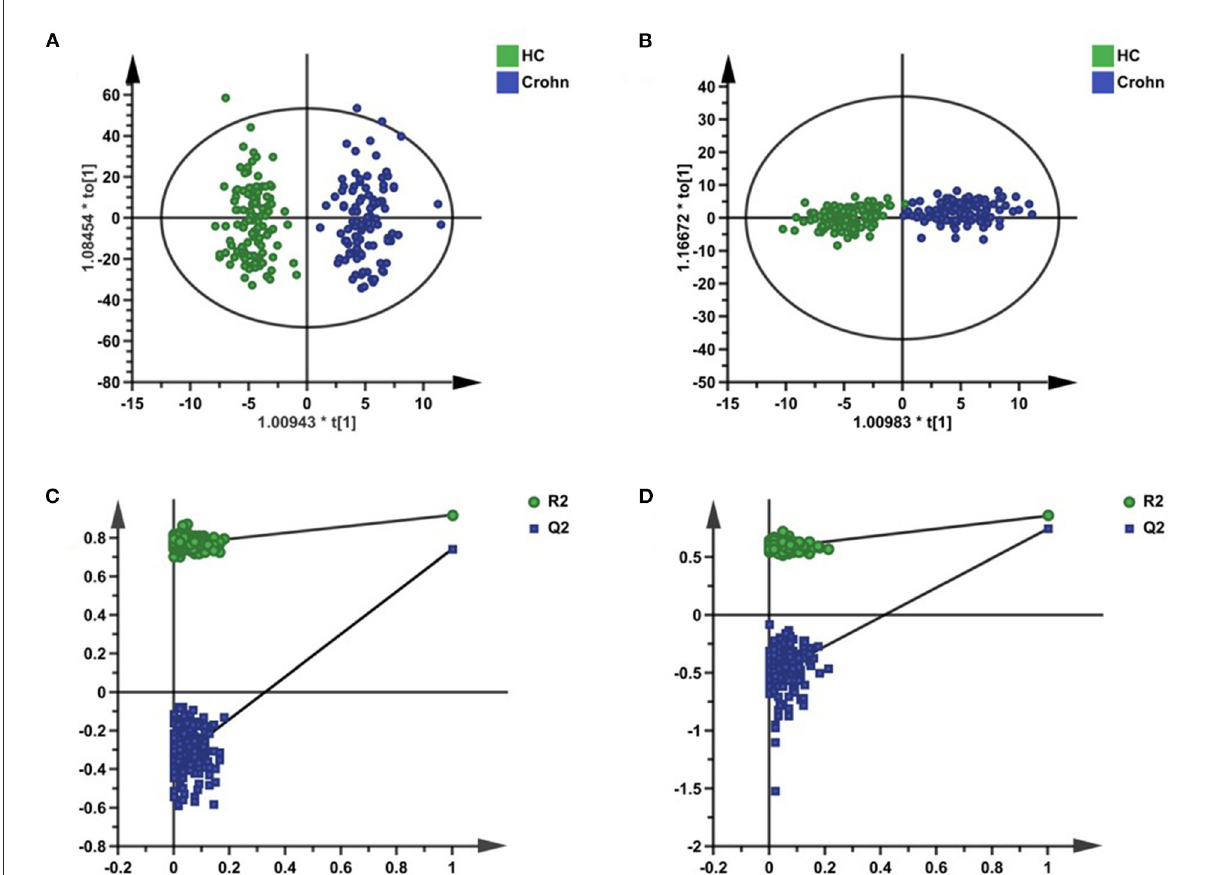
FIGURE2 Multivariate statistical analysis of serum metabolites in the discovery set. (A,B) The OPLS-DA scatter plots were based on the serum metabolic profiles of CD patients and HCs in positive ion mode and negative ion mode. (C,D) The 200-time permutation plots of two OPLS-DA